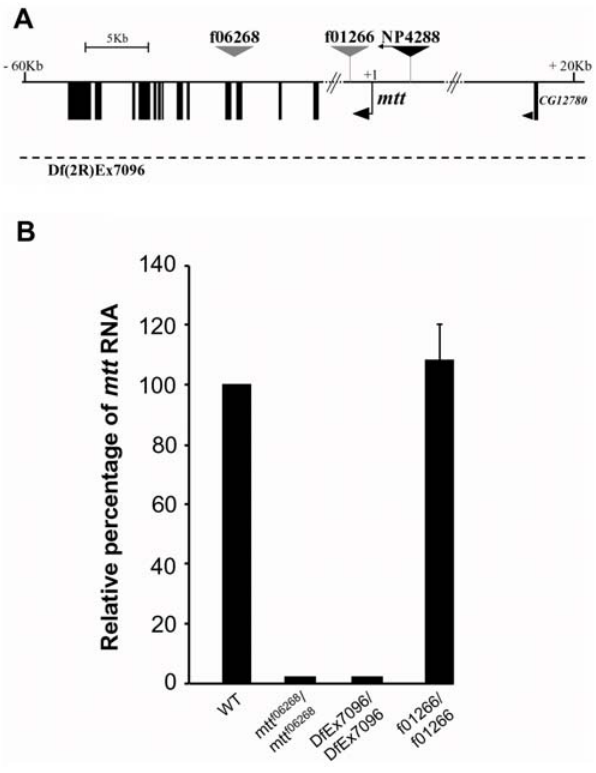
Figure 4. The f06268 and the DfEx7096 lines are mtt null mutants. (A) Schematic diagram showing the structure of the mtt gene and the insertion sites of the transposon lines used in this study. Black boxes show coding regions of mtt and CG12780 cDNAs. Black arrow shows the most distal transcription start site ( + 1) of mtt (predicted by Flybase). Arrowhead indicates the orientation of transcription of the CG12780 gene. The f06268 line carries a piggyBac transposon inserted 35 bp downstream the third mtt exon. The f01266 piggyBac transposon and the NP4288-GAL4 enhancer trap lines are inserted 1.7 Kb downstream and 3.1 Kb upstream, respectively, from the transcription start site of mtt . The Df(2R)Exel7096 line corresponds to a small deficiency that completely removes the mtt locus and some adjacent genes (CG8697 to CG2397). (B) QRT-PCR analysis on mtt mutants. The expression levels of mtt RNA on homozygous wild-type (WT), f06268 , Df(2R)Ex7096 , and f01266 adults flies were measured by quantitative real-time reverse-transcriptase polymerase chain reaction (QRT-PCR). WT and f01266 homozygous flies show comparable levels of mtt RNA, whereas no amplification is obtained from the f06268 and the Df(2R)Ex7096 homozygous lines. Error bar indicates SEM.